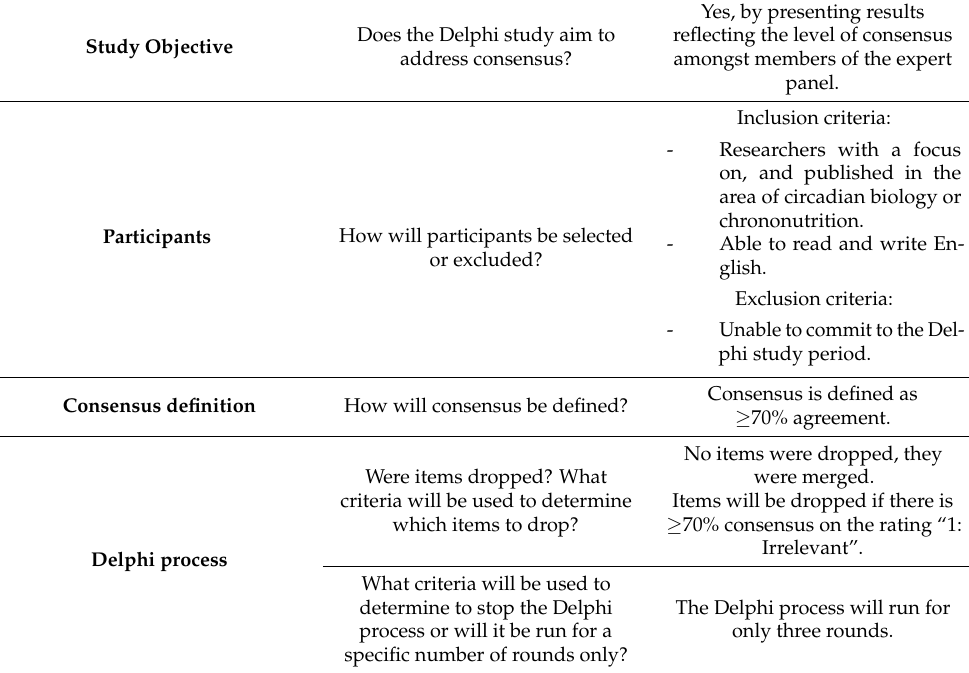
Table 1. Quality indicators in reporting Delphi methodology as recommended by Diamond, Grant, and